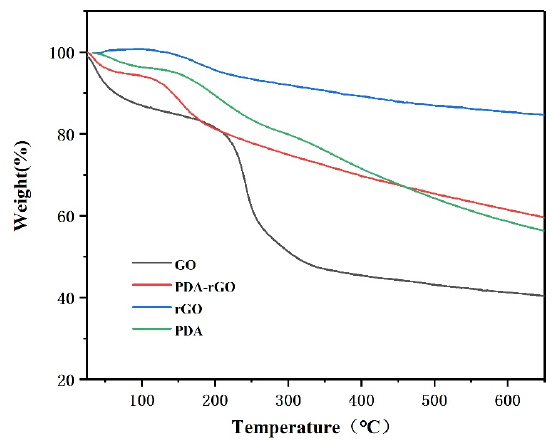
Figure 6. TGA curves of GO, rGO, PDA-rGO, and PDA.